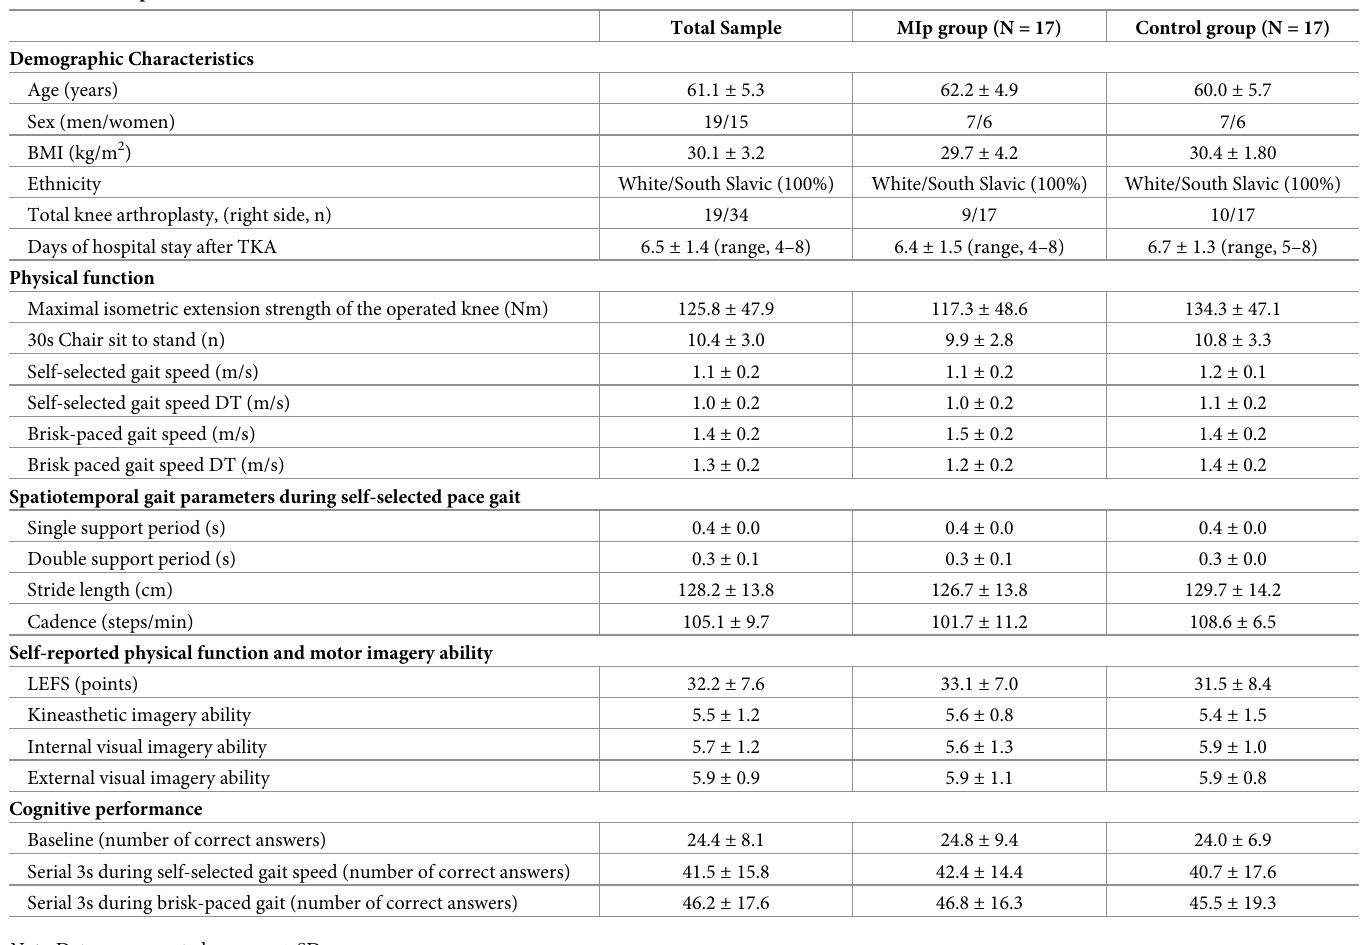
Table 1. Participants’ characteristics